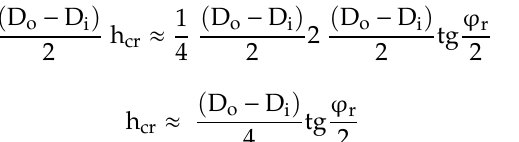
Figure 8. Arrangement of rotor poles and rotor yoke.